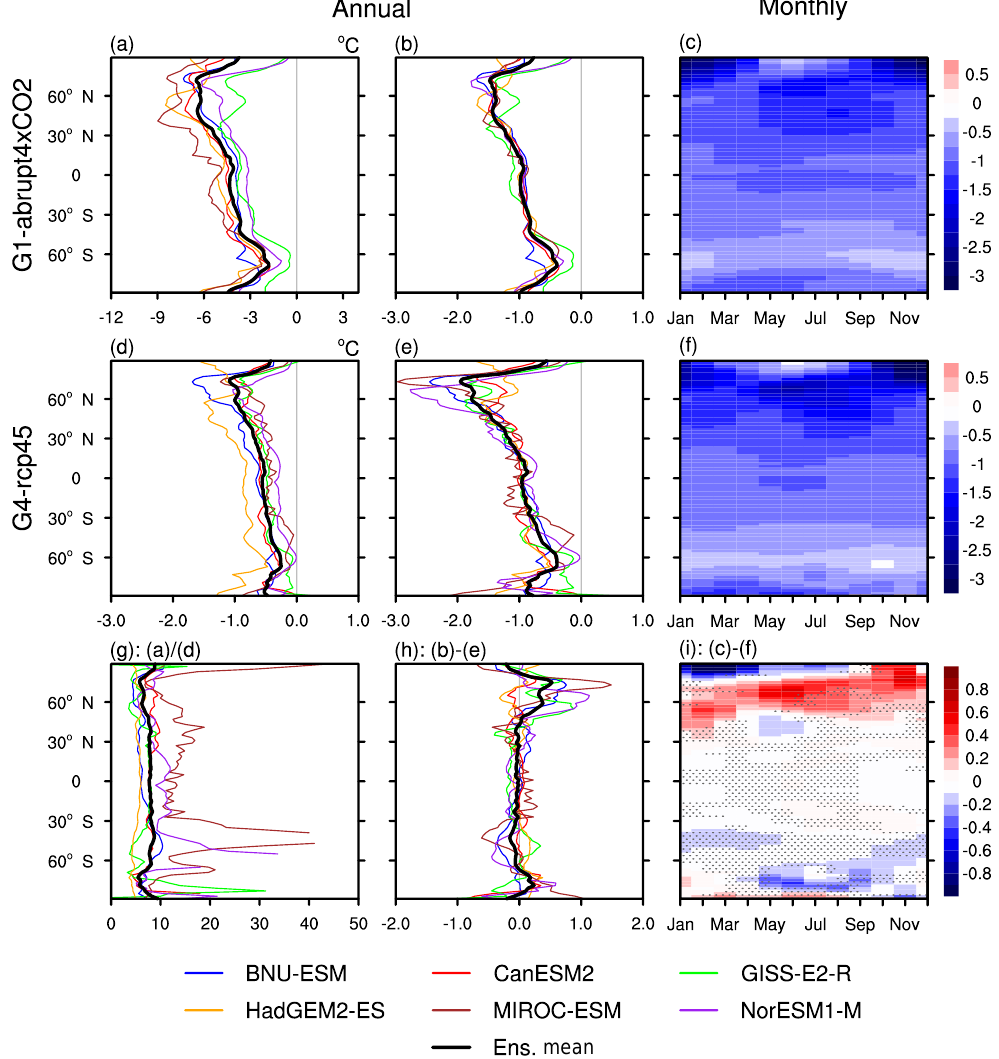
Figure 7. Absolute difference in annual zonal mean in the extreme high temperature TXx (a, d) . Normalized difference with respect to annual zonal mean (b, e) and monthly zonal mean (c, f) in TXx: (a, b, c) G1 − abrupt4 × CO2, (d, e, f) G4 − rcp45, (g) the ratio between absolute G1 − abrupt4 × CO2 and G4 − rcp45, (h) the annual zonal mean difference between normalized G1 − abrupt4 × CO2 and G4 − rcp45, and (i) the monthly zonal mean difference between normalized G1 − abrupt4 × CO2 and G4 − rcp45 taken over the 40-year analysis period. In panel (i) , red colours indicate relatively greater changes with G4 and blue colours indicate this with G1; stippling indicates regions where fewer than five of six models agree on the sign of the model response. Three by three point smoothing was applied to the seasonal latitude